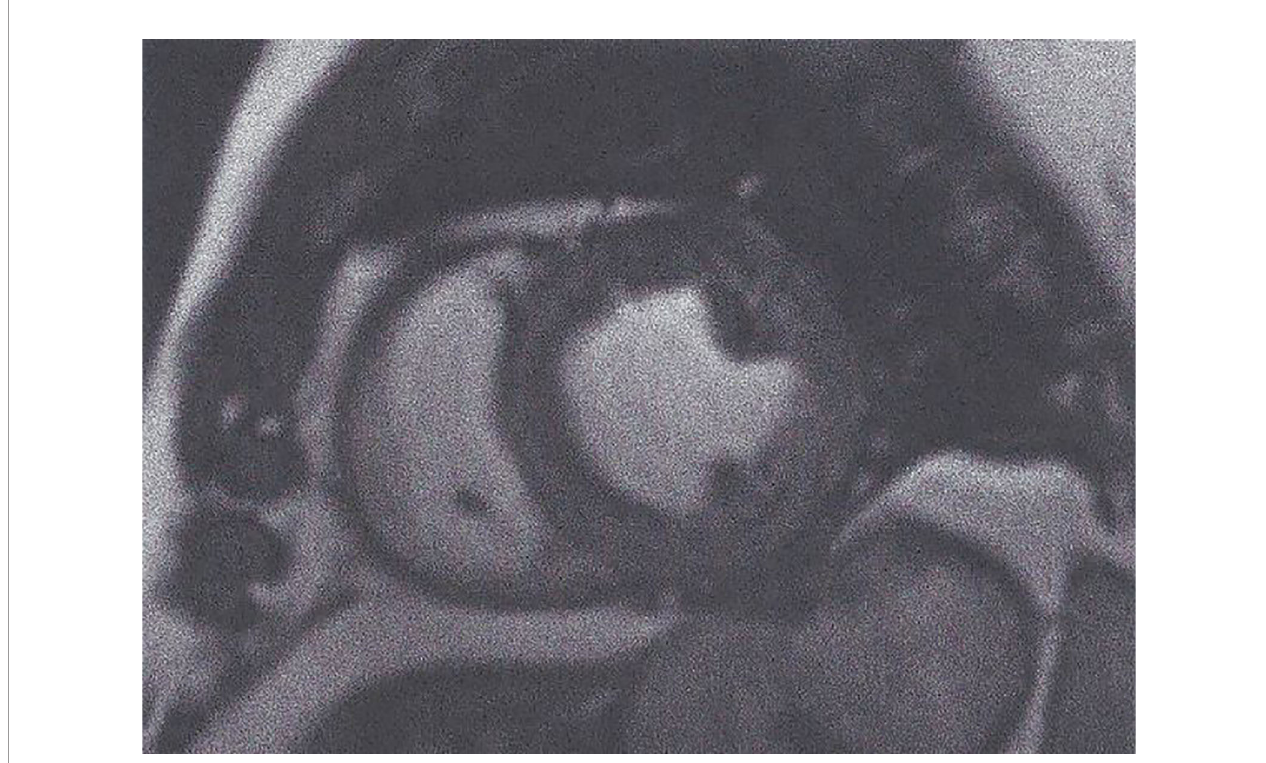
FIGURE 1 | Short axis SSFP image used for myocardial function assessment. This fi gure is original and based on data from Mavrogeni et